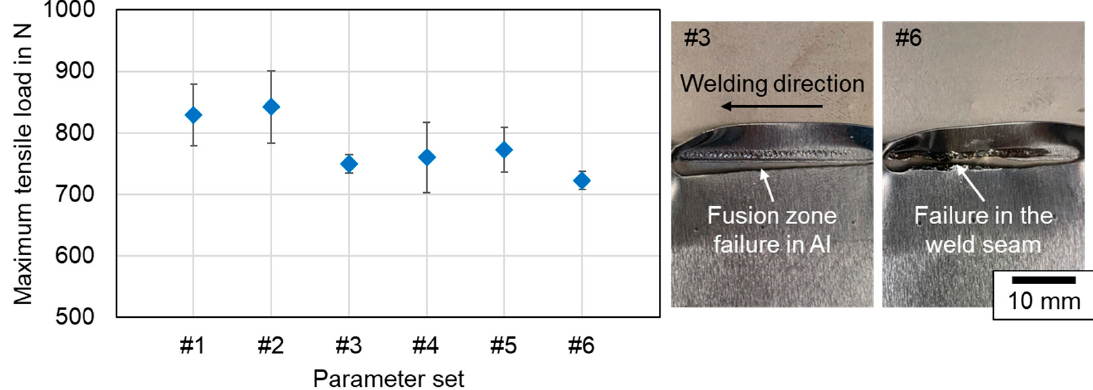
Figure 23. Tensile-shear strength result comparison for parameter sets #1–#6 (see Table